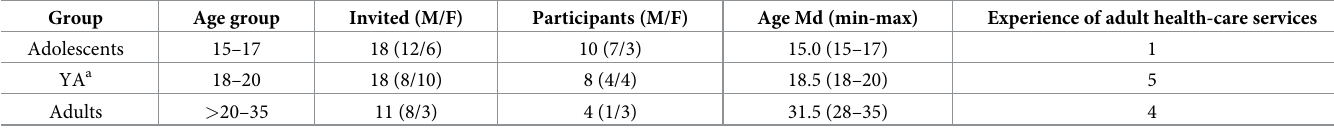
Table 1. Invited individuals and participants per age